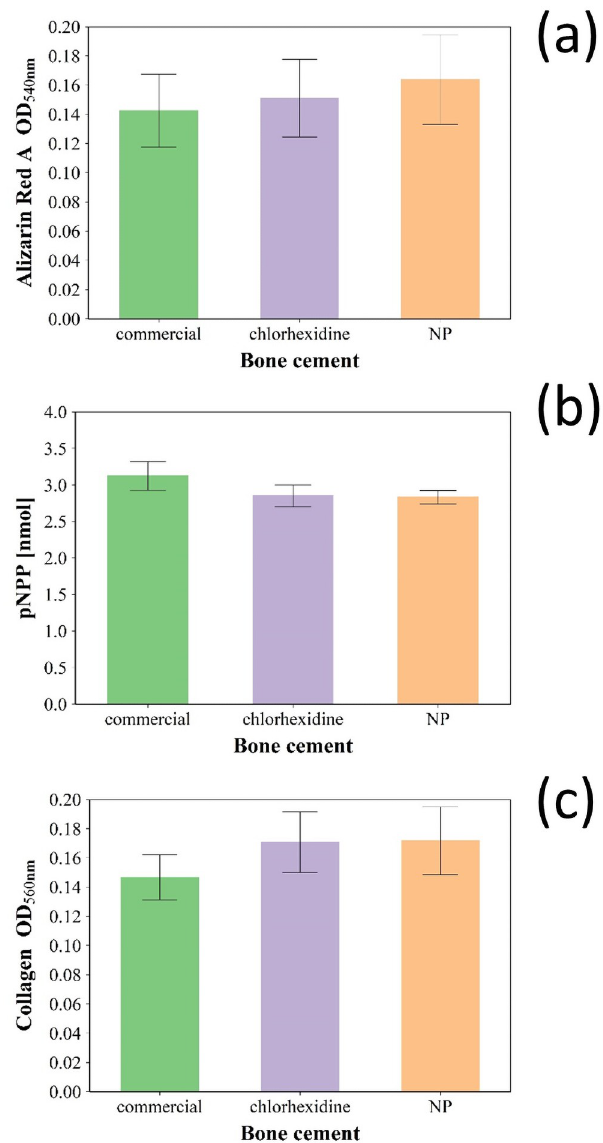
Fig 8. Evaluation of osteoblasts activity. (a) Quantification of the mineralisation of Saos-2 cells with alizarin red S after 21 days of exposure to release media. (b) ALP activity quantification in Saos-2 cells after 7 days of exposure to release media. (c) Collagen excreted by Saos-2 cells quantification after 7 days of exposure to release media. Cemex 1 bone cement (green). Cemex 1 containing chlorhexidine powder 3% w/w (violet) and coated silica nanoparticles (orange) (mean ± SD, n =